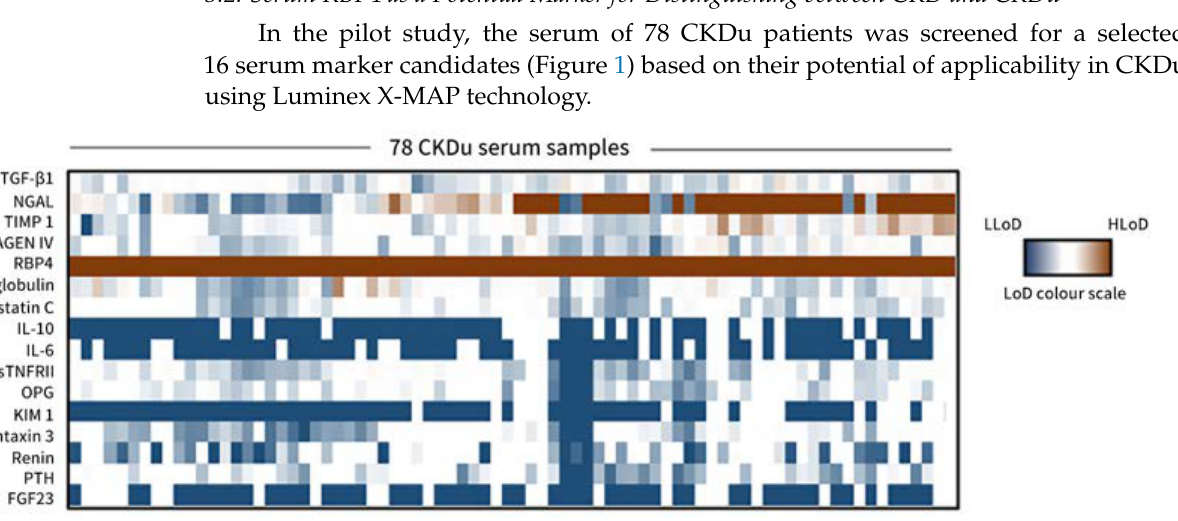
Figure 1. Heatmap showing expression level of serum analytes with respect to limit of